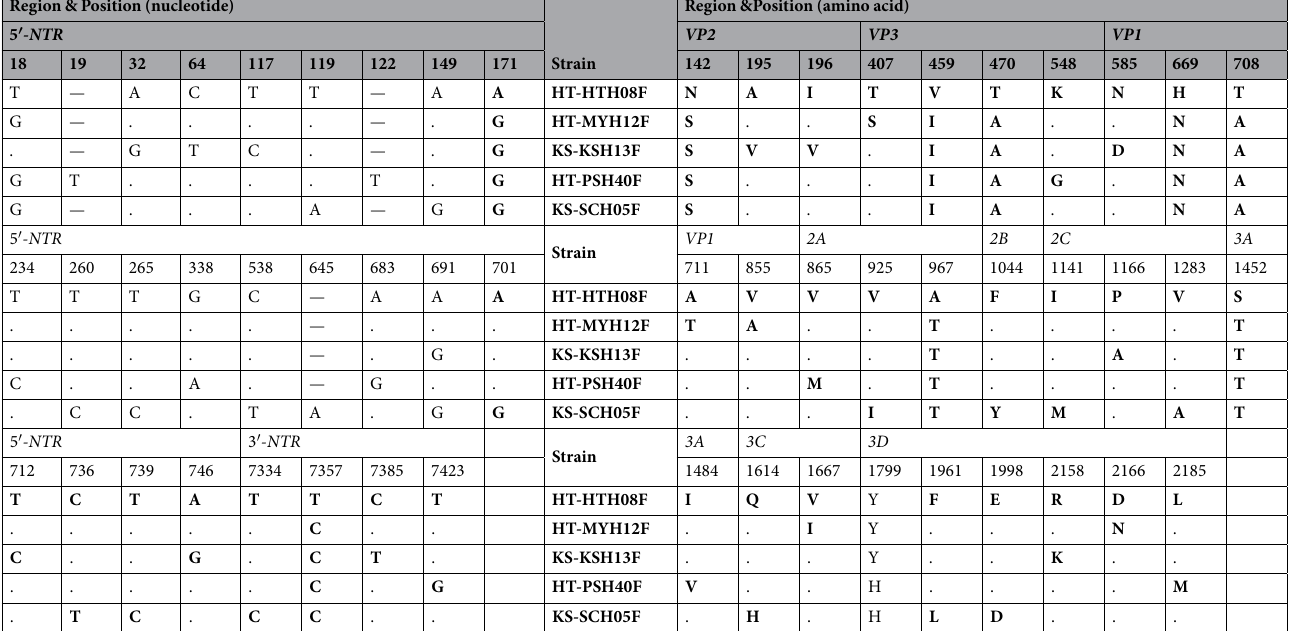
Table 4. 26 nucleotide substitutions in NTR and 29 amino acid substitutions in ORF among five EV-A90 strains. The position of nucleotide was calculated from the first nucleotide of its NTR after a multi-alignment by ClustalW. But there was no observation in VP4 and 3B